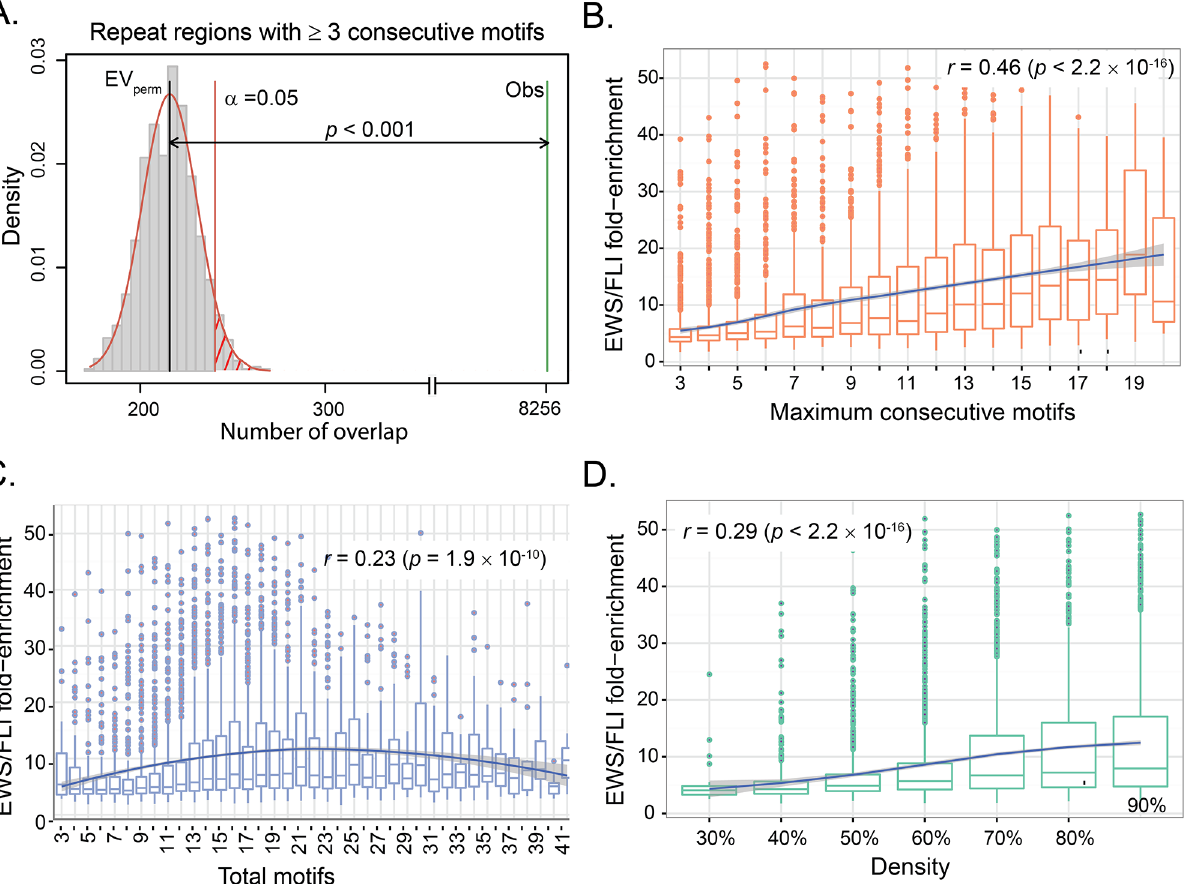
Fig 3. Characteristics of EWS/FLI-bound microsatellites. ( A ) Permutation test shows that the number of EWS/FLI bindingsites that overlap with repeat regions ( n = 8,256) with minimumof 3 consecutivemotifs is significantly higherthan randomchance ( p < 0.001). Red line denotes the significancelimit ( α = 0.05). Gray bars represent the number of overlaps in the random regionswith EWS/FLI bindingsites in 1,000 permutations. The black line represents the mean of overlaps in randomregions (EV perm ) and the green bar is the actual numberof overlaps observedin repeat regions (Obs). ( B ) Boxplot of EWS/FLI fold-enrichment (relative to genomicbackground) and number of consecutivemotifs in EWS/FLI-bound microsatellites showingstatisticallysignificantincreasingtrend ( p < 2.2 × 10 − 16 ). The blue line is the estimated LOESS regression line of the mean with the estimated 95% confidencebands(shadedregion). ( C ) Boxplot of EWS/FLI fold- enrichmentand total number of motifs in EWS/FLI-bound microsatellites showinga positive correlation( p = 1.9 × 10 − 10 ) and a non-linear trend ( p < 0.05). The blue line is the estimated LOESS regressionline of the mean with the estimated 95% confidencebands (shaded (cid:16) (cid:17) (cid:2) 100% region). ( D ) Boxplot of EWS/FLI fold-enrichment and Density ¼ total motif (cid:2) 4 showingstatistically significantpositive correlation length of microsatellite ( p < 2.2 × 10 − 16 ). The blue line is the estimated LOESS regression line of the mean with the estimated 95% confidencebands (shaded region).